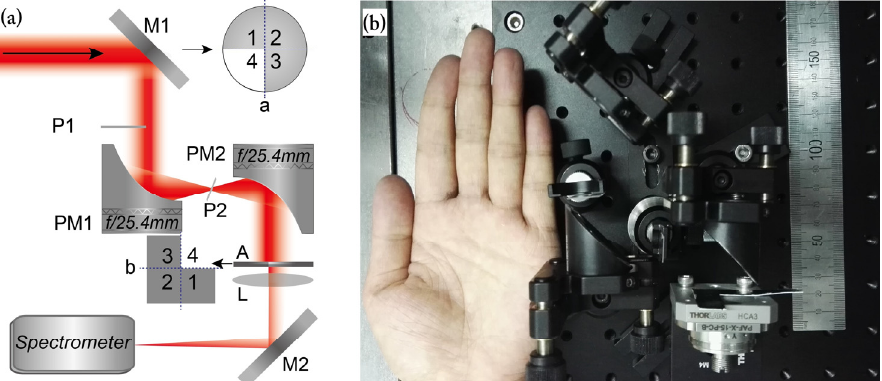
Figure 18. Setup of enhanced TG-SRSI. ( a ) M1, special three-fourths-coated reflective mirror; P1, 0.5-mm-thick fused silica plate; PM1 and PM2, 90° off-axis parabolic aluminum mirrors, f = 25.4 mm; P2, 0.15-mm-thick YAG plate; A, aperture; L, lens, f = 200 mm; M2, reflective mirror; inset a, the front side of M1; inset b, the shape of A. ( b ) Photo of the optical setup of the device [63].